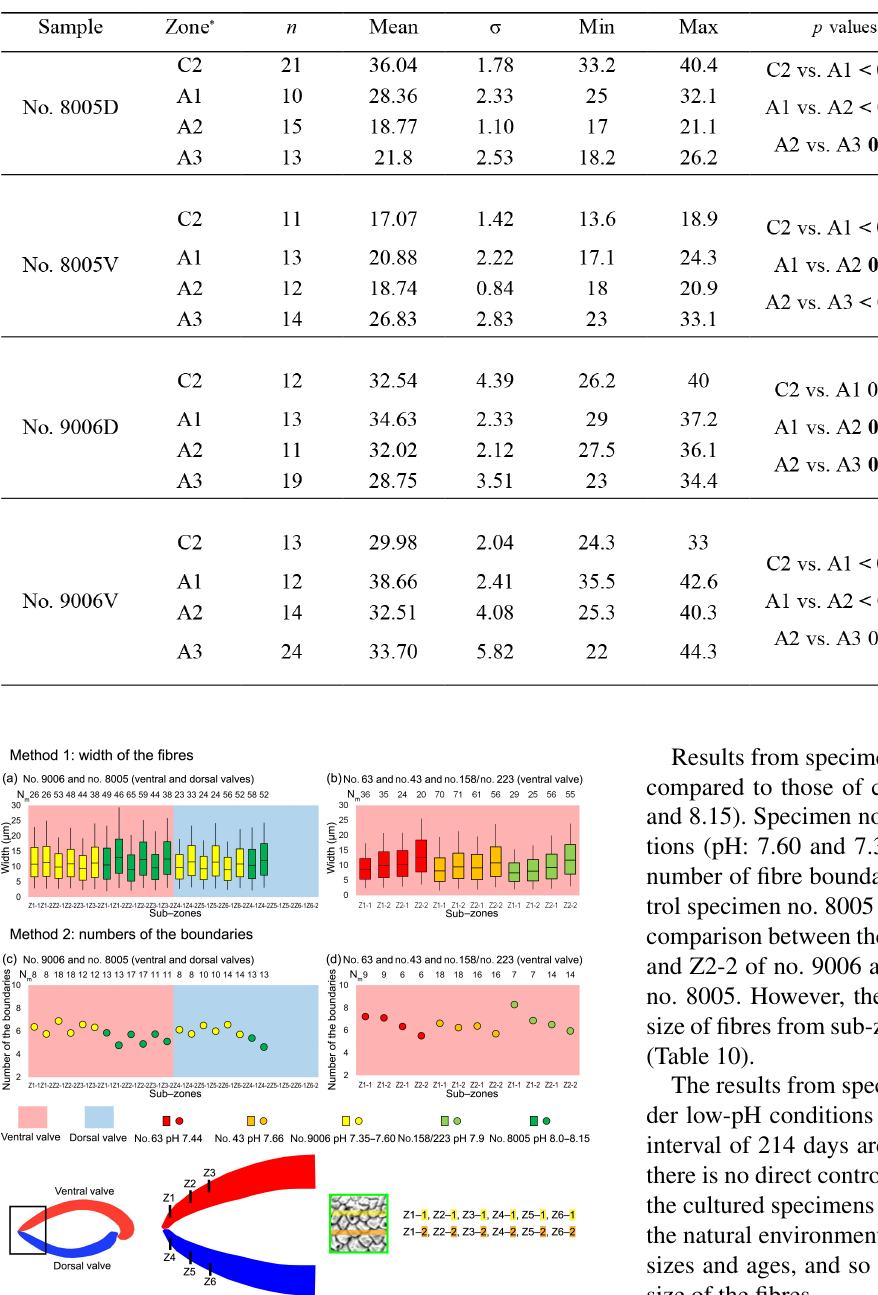
Figure 9. Differences in sizes of fibres of M. venosa (ventral and dorsal valves) in the anterior transverse sections of specimens cul- tured under different pH conditions. (a, b) The bottom/top of the box and the band inside the box are the first/third quartiles and the median of the data, respectively; ends of the whiskers represent the minimums and maximums. (c, d) Circle point represents average data; N m : number of